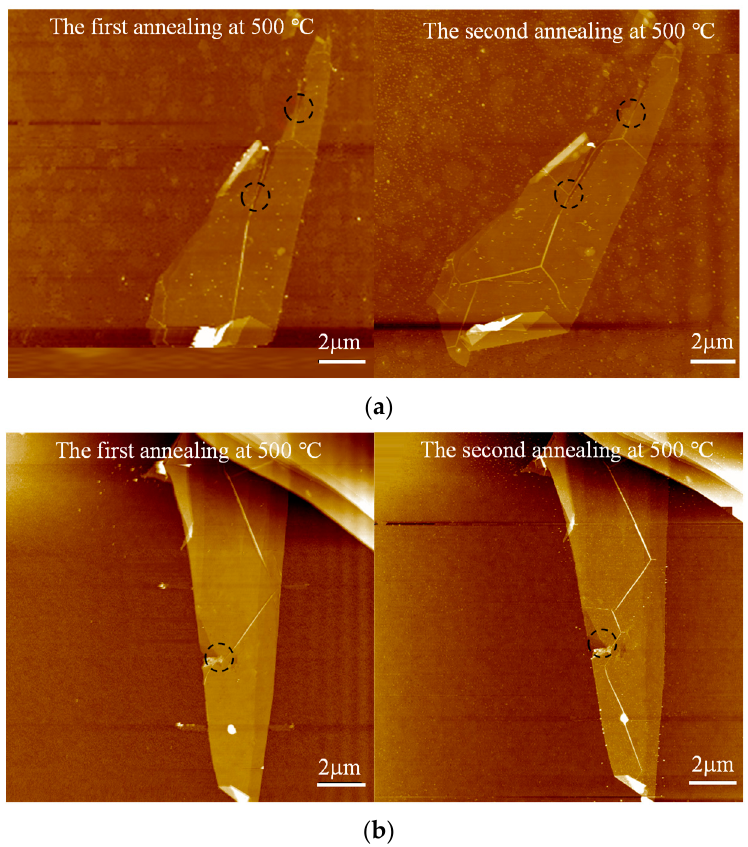
Figure 8. Morphological changes of wrinkles of h-BN flakes with cracks after twice annealing: ( a ) A slender crack. ( b ) Triangular crack (The dashed circle describes the position of the crack).